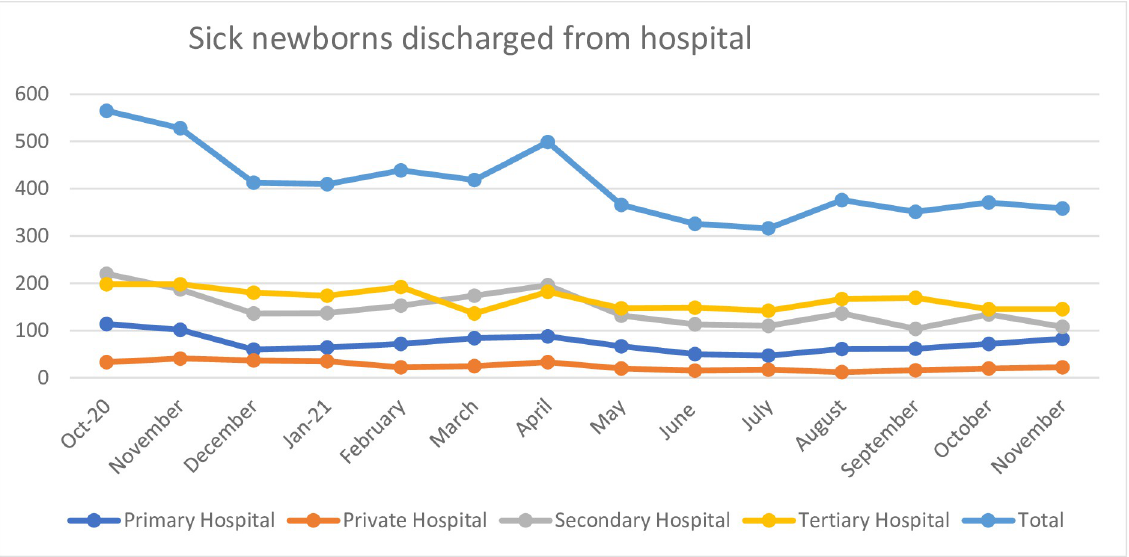
Fig 4. The run chart depicting the association of HBB program with sick newborns transferred from the maternity/pediatric unit over the program period.